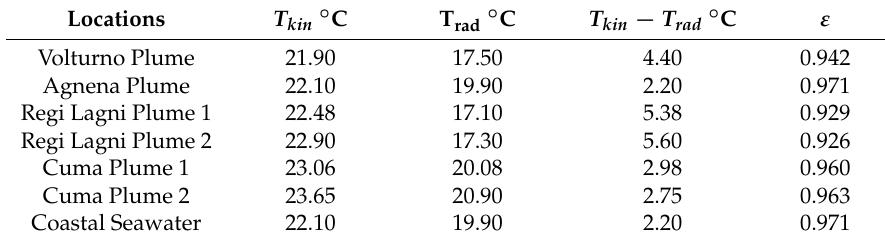
Table 3. Water in situ kinetic temperature, T kin ( ◦ C), IR thermographic radiometric temperature, T rad ( ◦ C), the difference of T kin and T rad , and the derived emissivity, ε , for the areas of interest.